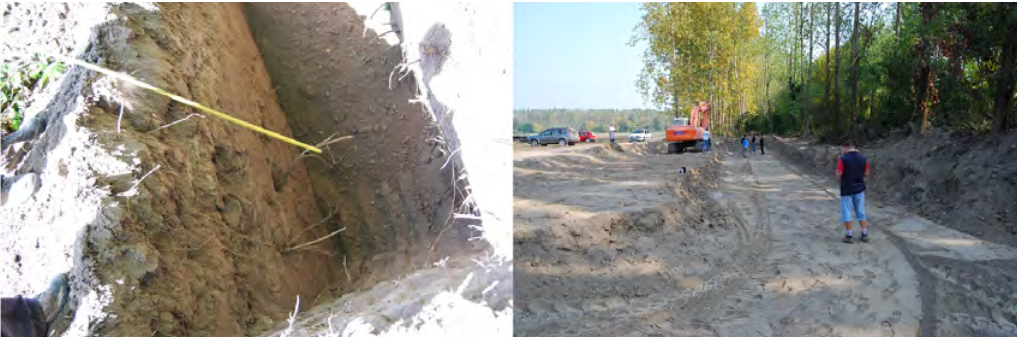
Figure 9. Depth of the roots (left) and the size of the first of four test fields prepared to study the roller compaction efficiency (right).